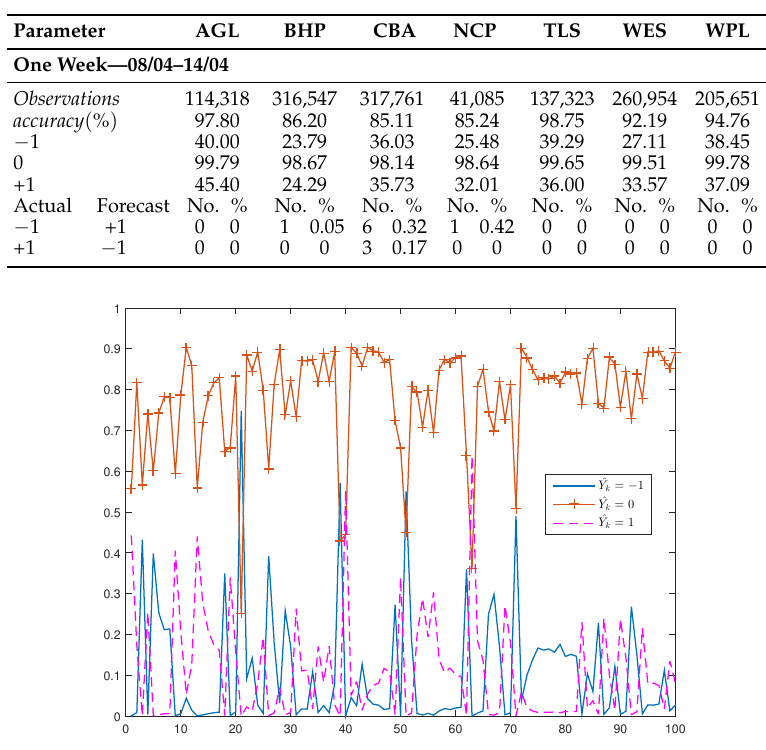
Table 8. In-sample predictions of direction of price change for the last one week period of the training sample from 8 April 2014 to 14 April 2014.